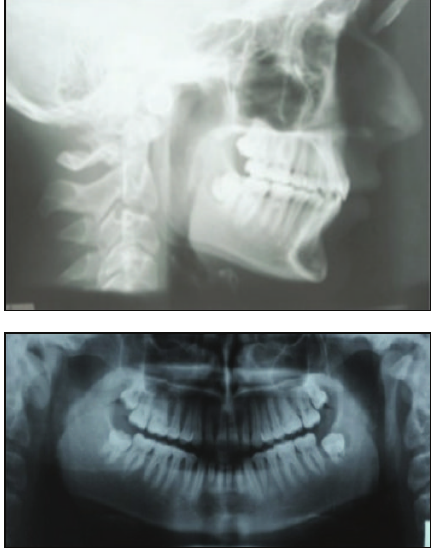
Figure 5: Posttreatment lateral and panoramic